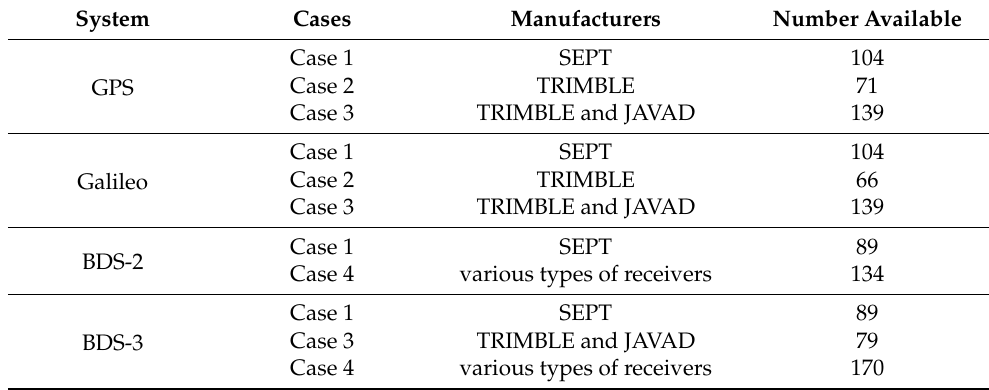
Table 4. Network strategies of phase bias